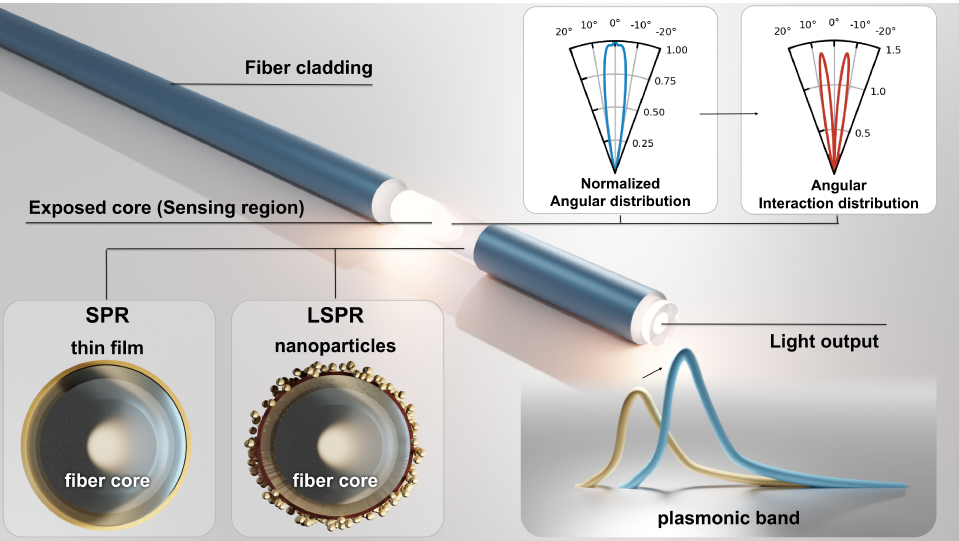
Figure 1. Multi-mode fiber with a decladded section exposing the core light to a plasmonic nanos- tructure; a thin film or nanoparticles deposited on its surface, exciting a SPR or LSPR band, corre- spondingly. Moreover, in the case of multi-mode fiber, there is a certain angular distribution and an interaction factor proportional to the traveling light